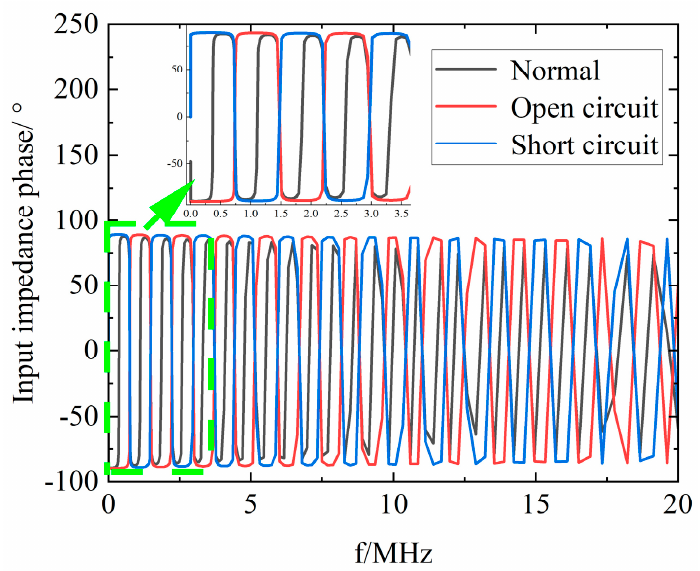
Figure 6. Headend input impedance phase spectrum of normal operation, open circuit, and short circuit cables.